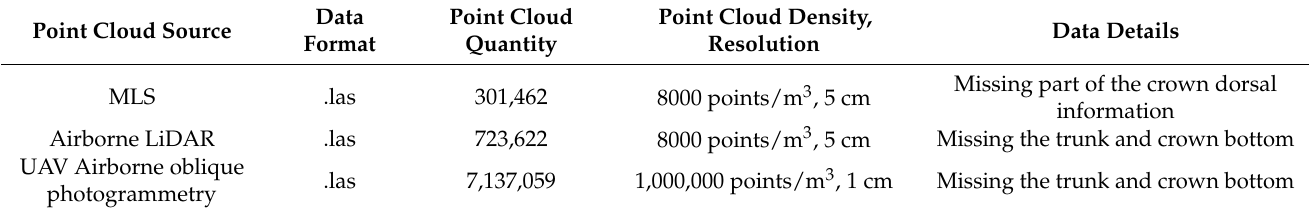
Table 5. Quality comparison of three point cloud datasets collected from the same complex vegetation coverage